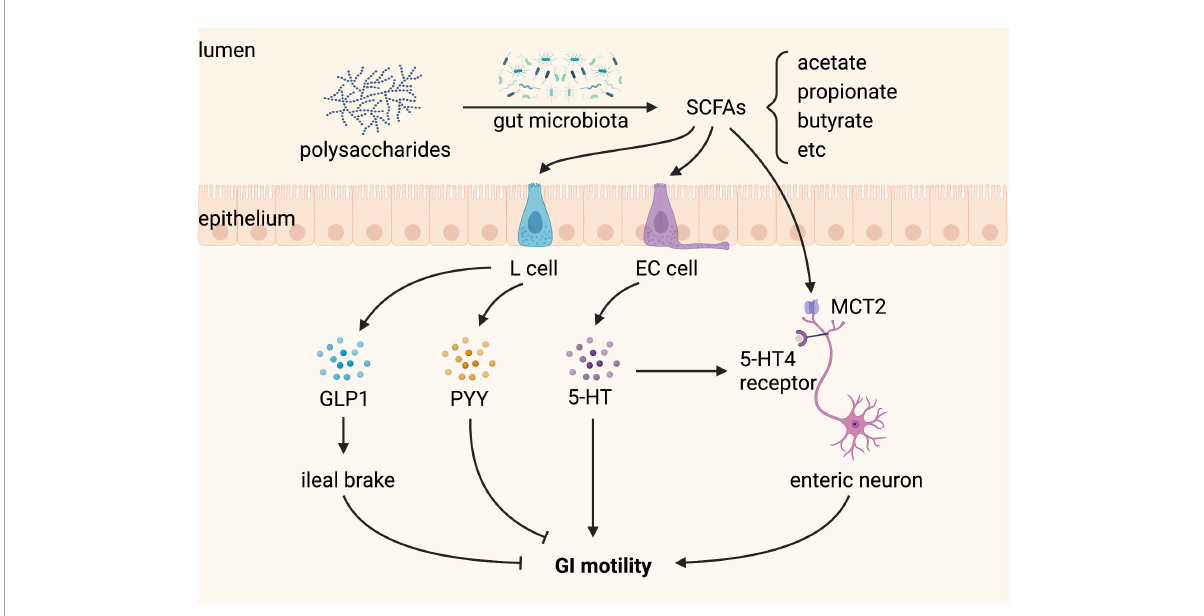
FIGURE5 Short-chain fatty acids (SCFAs) produced by gut microbiota regulate gastrointestinal (GI) motility. SCFAs, including acetate, propionate, and butyrate, are produced from gut microbial fermentation of dietary polysaccharides. L cells sense SCFAs and produce glucagon-like peptide 1 (GLP-1) and peptide YY (PYY), both of which inhibit GI motility. Enterochromaffin (EC) cells sense SCFAs and produce 5-hydroxytryptamine (5-HT), which promotes GI motility by activating the 5-HT4 receptor expressed on enteric neurons. SCFAs can also stimulate enteric neurons through monocarboxylate transporter 2 (MCT2), playing a positive role in GI motility.